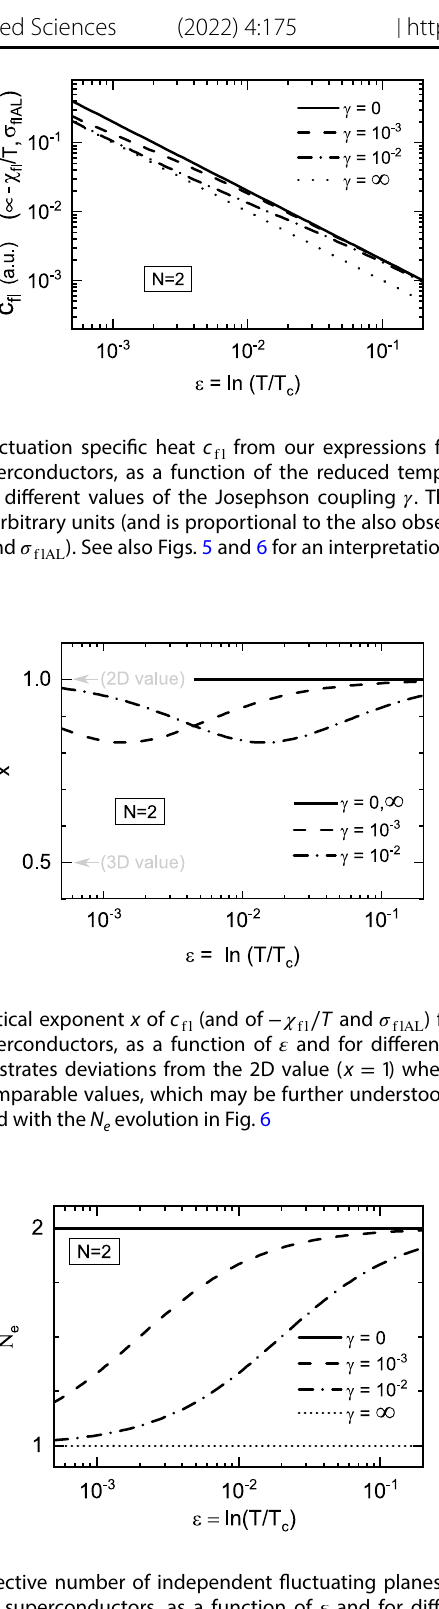
Fig. 6 Effective number of independent fluctuating planes, N e , for two-layer superconductors, as a function of 𝜀 and for different 𝛾 . The figure illustrates crossovers between the N e = 1 and 2 values as 𝜀 and 𝛾 vary, and with them the corresponding inter-plane cor- relations. These crossovers may be correlated with the evolutions of the critical exponent x in Fig.